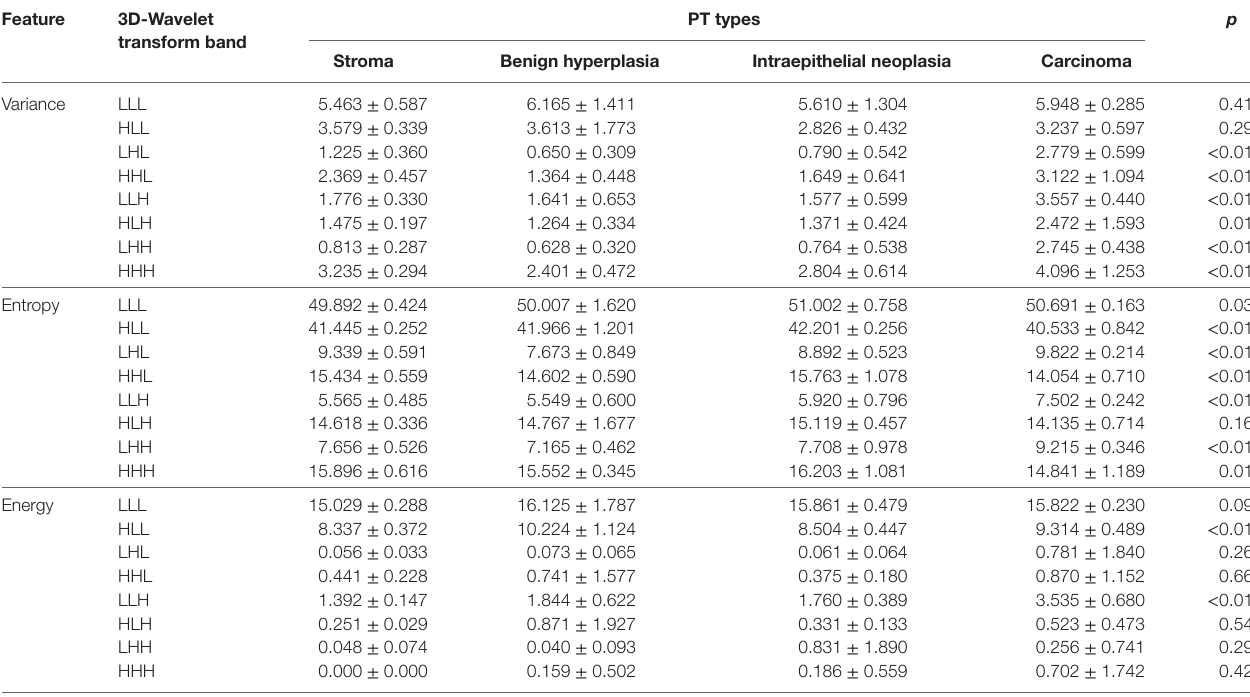
TaBle 2 | Average ± SD for each of features across 3D-WT bands and four pathology tissue (PT) types.